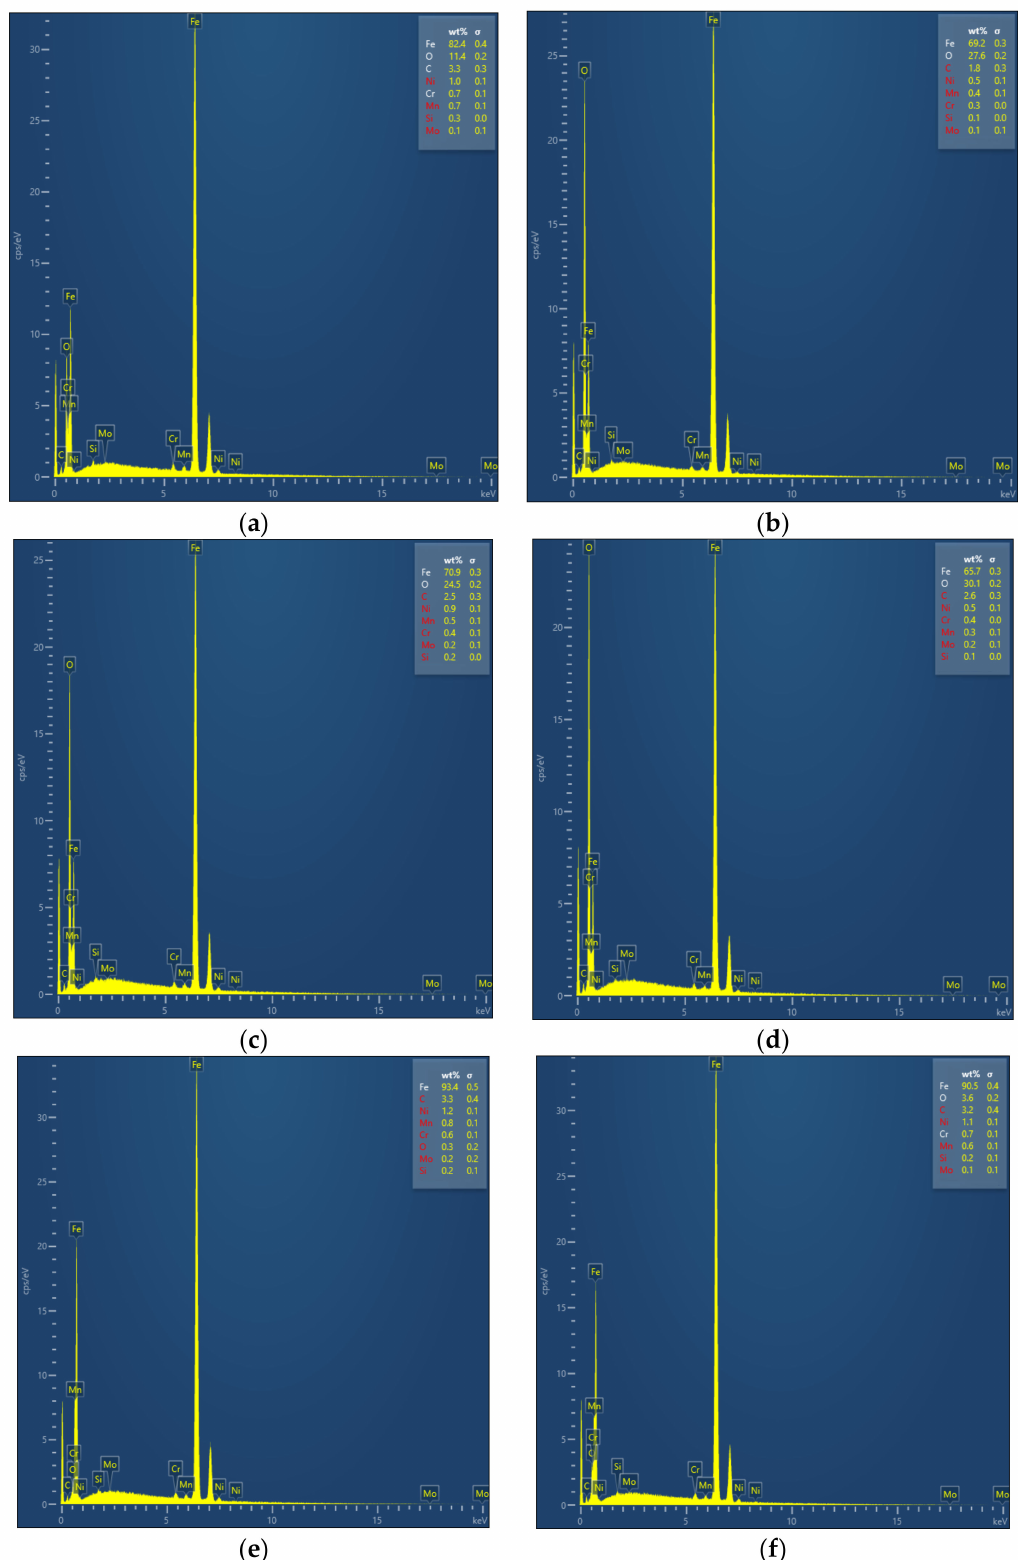
Figure 30. ( a – f ) corresponds to the EDS analysis results of the debris in Figure 29 marked in